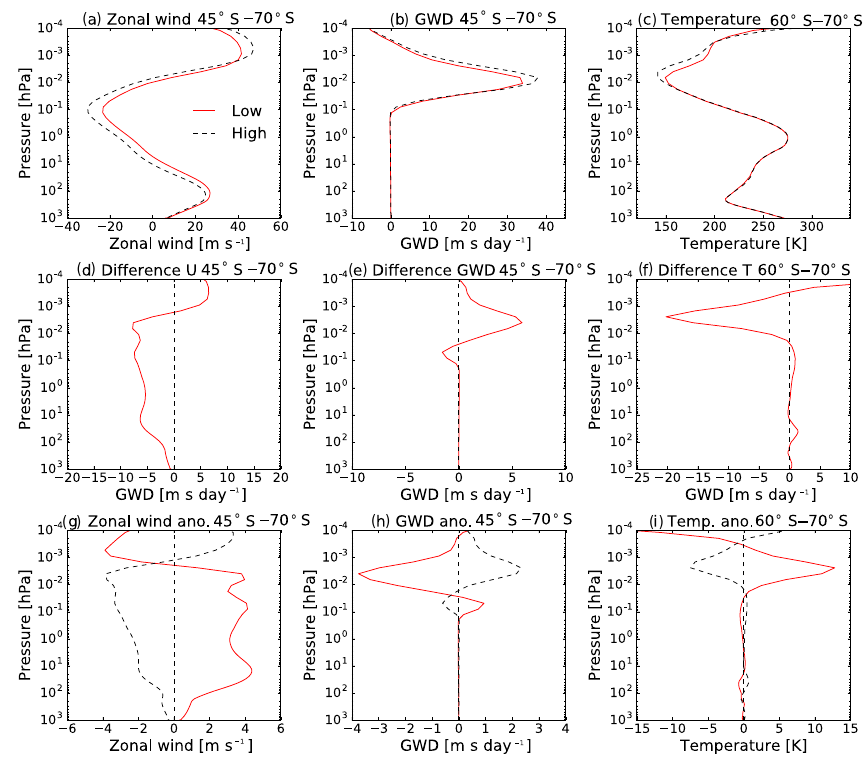
Figure 8. The January zonal wind (a, d, g) and the GW drag (b, e, h) between 45–70 ◦ S and the temperature (c, f, i) between 60–70 ◦ S for anomalously low and high temperatures in the winter stratosphere (1–10hPa, 50–60 ◦ N) (a–c) and the differences between them (d–f) and their anomalies (g–i) , for the case where there are no GWs in the winter hemisphere. The red continuous lines show the results for anomalously low temperatures and the black dashed lines show the results for the anomalously high